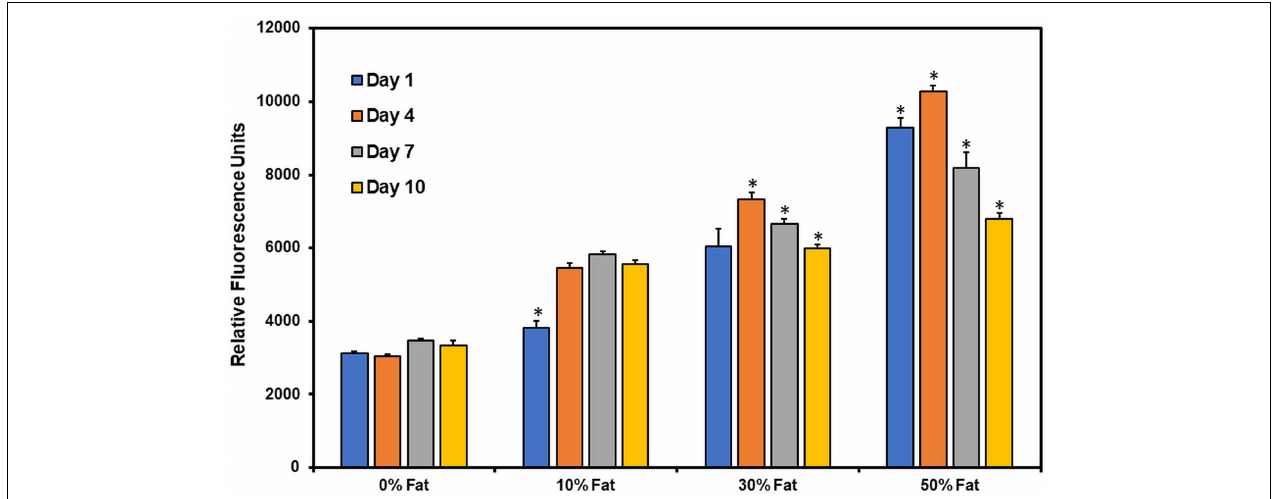
FIGURE 4 | Quantification of cell metabolic activity in microfat-laden collagen constructs over time using Alamar blue assay. (* indicates p < 0.05 when comparing between different time points for the same microfat